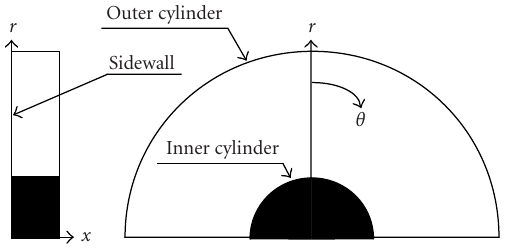
Figure 1: Schematic diagrams of axially rotating drum and their coordinates.